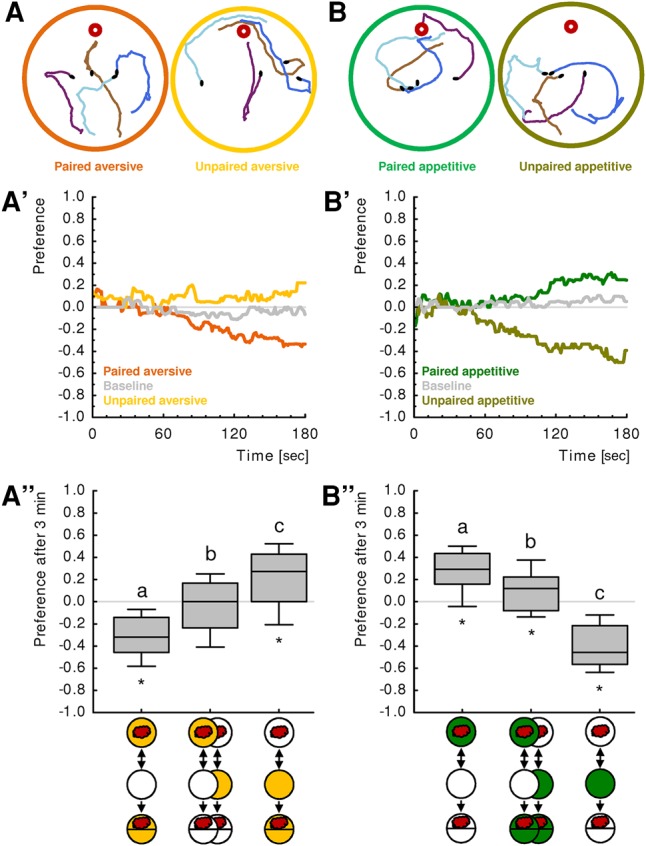
Olfactory preferences after (A–A″) aversive training and (B–B″) appetitive training. (A,B) show example tracks, (A′–B′) the animals’ preferences over time as detected by the software; (A″–B″) preferences as based on manual counting after 3 min. (A) Representative example tracks of individual animals after paired (left) and unpaired (right) aversive training. Black dots represent the starting positions of the animals; the small red circle shows the position of the odor source. (A′–A″) After paired aversive training, larvae avoid the odor whereas after unpaired aversive training (i.e., presenting odor and quinine separately, in consecutive trials) they approach it. When tested in the absence of quinine, learned behavior is not observed; instead, the larvae display an intermediate baseline preference. (B) Representative example tracks of individual animals after paired (left) and unpaired (right) appetitive training. (B′–B″) After paired appetitive training, larvae approach the odor, whereas after unpaired appetitive training they avoid it. When tested in the presence of fructose, learned behavior is not observed; instead, the larvae display an intermediate baseline preference. Both after appetitive and aversive memory, preference differs across groups (P < 0.05, df = 2, N = 27, 56, 27, KW). Significant between-group differences (MWU, P < 0.05 corrected according to Bonferroni–Holm) are indicated with lower case letters above the boxes, significant differences to chance level (OSS, P < 0.05 corrected according to Bonferroni–Holm) are indicated by asterisks below the boxes. For a display of median and 25%–75% quantiles of the time-resolved preferences, see Supplemental Figure S8.